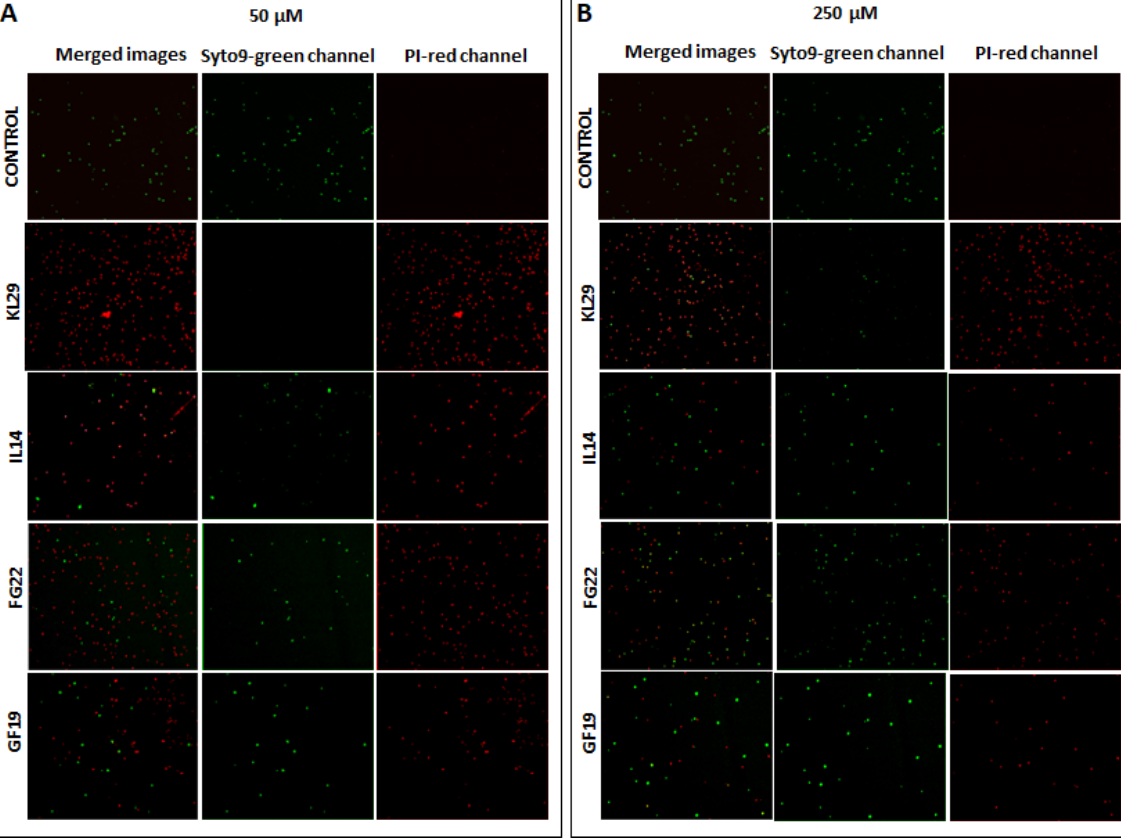
Figure 2. Fluorescence microscopy micrographs of untreated (control) and treated Erwinia amylovora cells with selected peptides at two concentrations ( A ) and ( B ) at 1 h. Viable and unviable cells are stained by SYTO9 (green fluorescence), while damaged dead cells were stained by propidium iodide, PI (red fluorescence). Magnification 40 X. The quantification of viable and unviable cells is reported in the Supplementary Table S2.